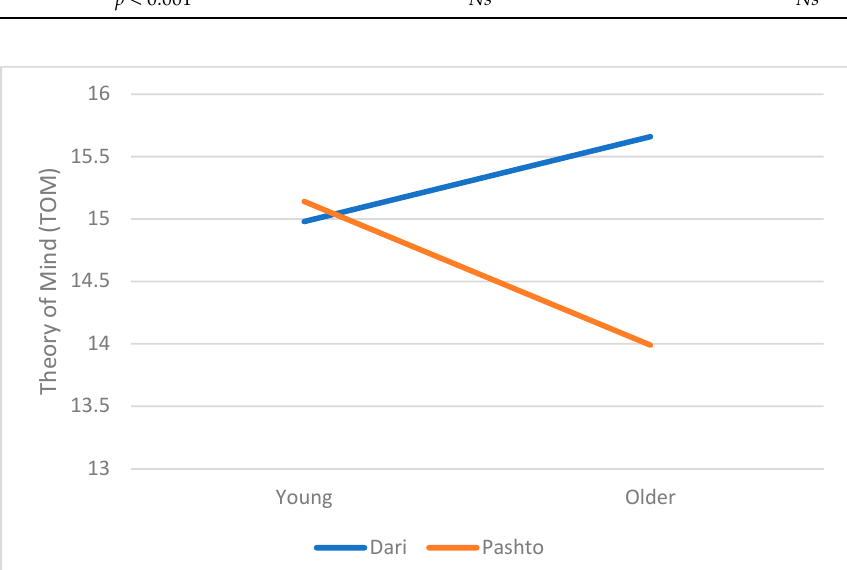
Figure 1. Theory of mind: A group × generation effect.